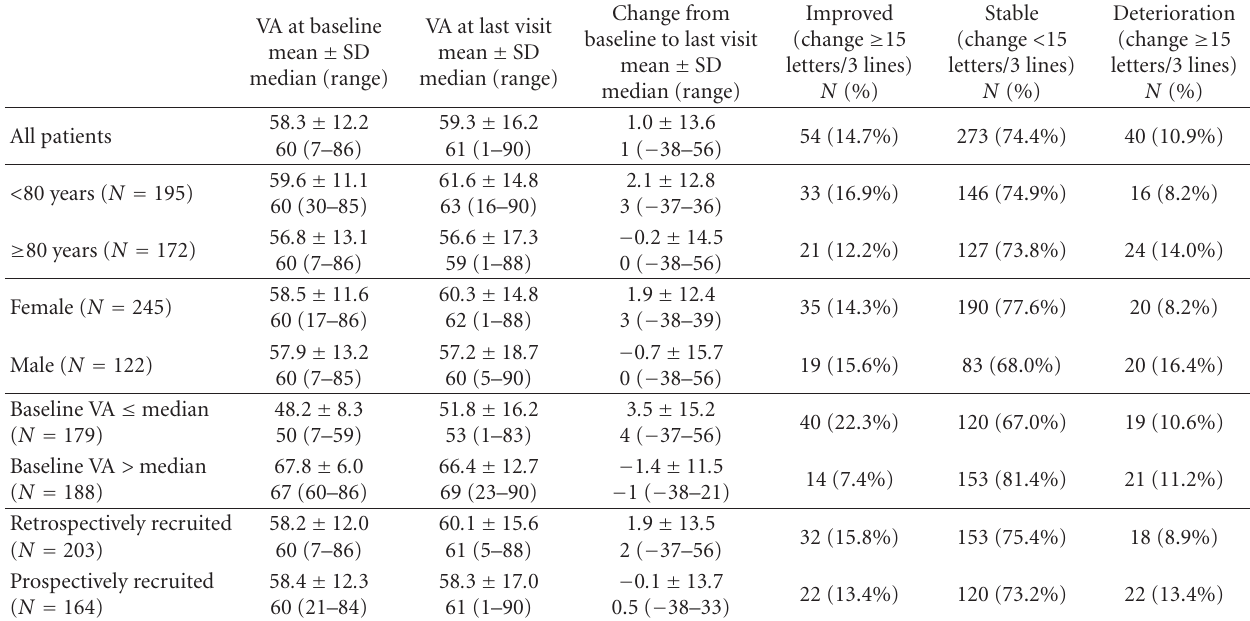
Table 2: Change in VA score from baseline to last visit (on-treatment population, n = 370 † ).